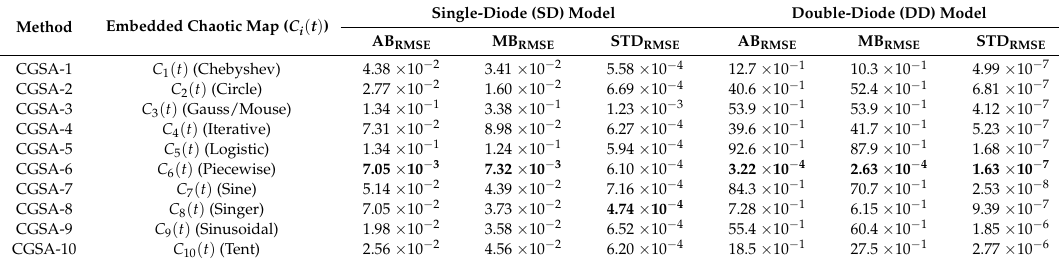
Table 1. CGSA minimization results for the SD and DD models (with G = 1000 W/m 2 and T c = 33 ◦ C), for 30 individual runs (with t = 4000 iterations each and N p = 100 search agents). Note that the best outcomes for each of the simulated solar cell models are